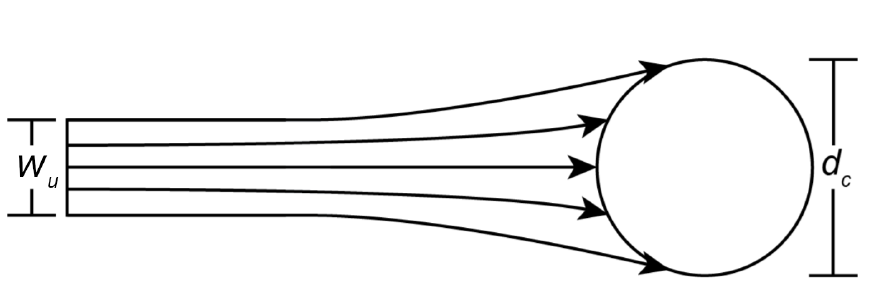
Figure 2. A diagram illustrating capture efficiency for a cylindrical collector. w u is the cross-sectional width of streamlines in the upstream flow containing particles that will ultimately be captured, and d c is collector diameter. Adapted from Palmer et al. (2004)